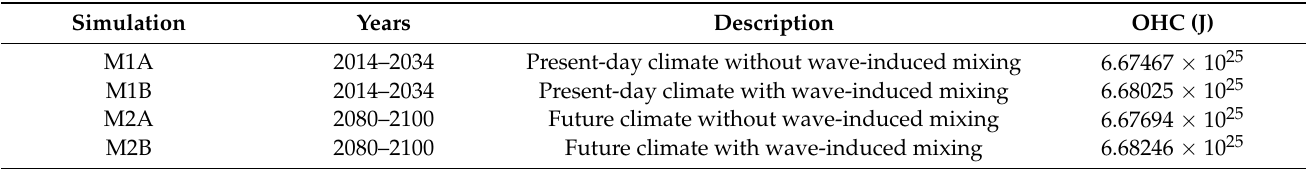
Table 1. A description of the four simulations. Ocean Heat Content (OHC) is the mean heat content within the upper 200 m of the ocean.